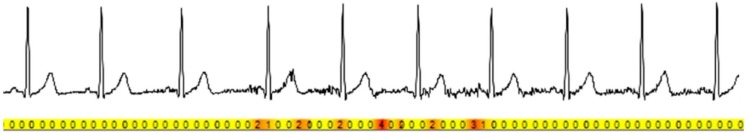
Data acquired from VitalJacket® wearable medical device captured during non-movement and movement. This figure shows an example of the medical grade ECG waveform acquired and below an activity intensity from the accelerometer acquired data.This intensity scale from the accelerometer goes from yellow (no movement, zero value) to red (high movement) showing the level of each participant activity.